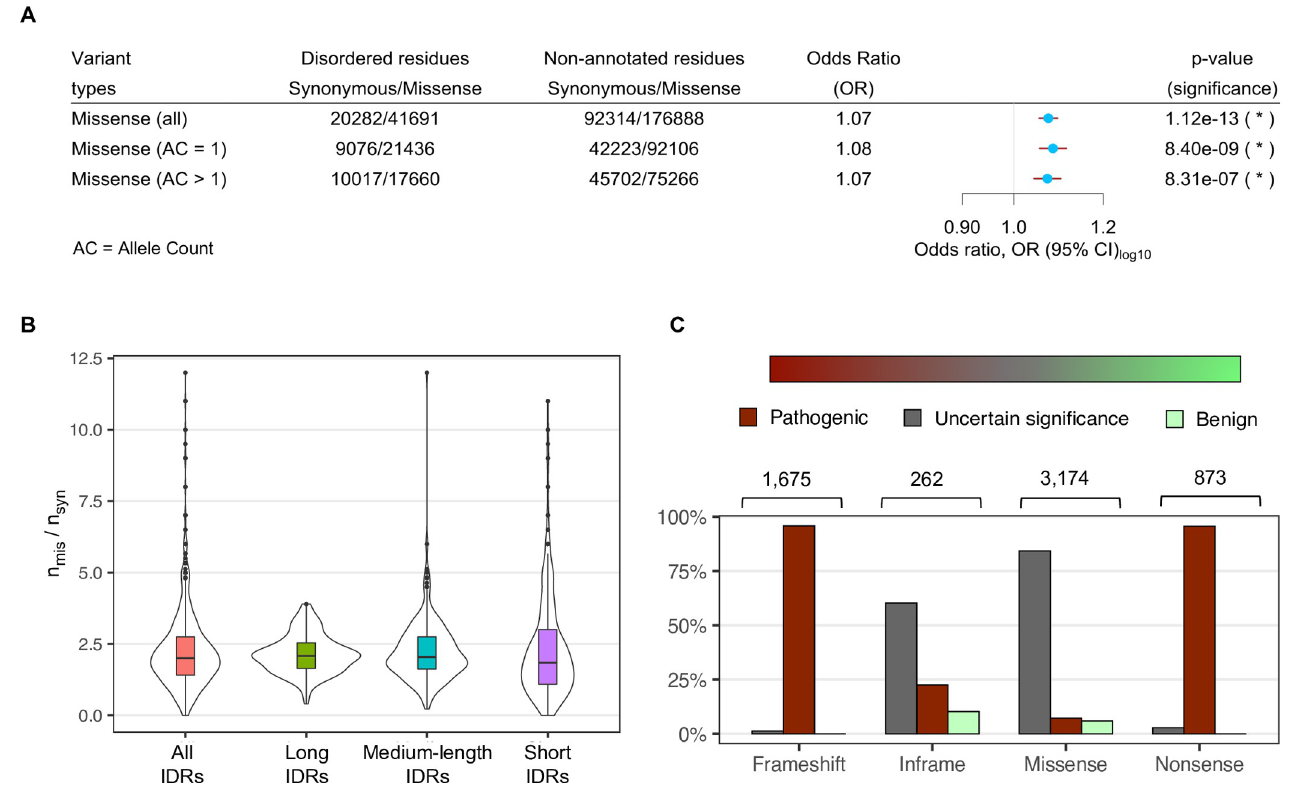
Fig 3. Genetic variations in disordered regions often provide functional advantages to the protein, while for many IDPs, they contribute to the disease phenotype. ( A ) Association of single amino acid-changing missense variations and silent synonymous variations from gnomAD database (a database of variants from relatively healthy individuals) with disordered residues compared to non-annotated residues of 548 human IDPs, calculated using the two-tailed Fisher’s Exact test. Missense variations are marginally (OR = 1.1) but significantly (indicated by “ � ”) enriched in disordered regions, considering all variants together, and also separately in rare (allele count, AC = 1) and frequent variants (AC > 1). ( B ) Distribution of ratios of missense to synonymous (n mis /n syn ) variations from gnomAD database in all IDRs, and short ( � 30 residues), medium-length (30 < residues � 100) and long ( > 100 residues) IDRs. Irrespective of the length, the median of missense-to-synonymous variation ratio in IDRs is over 2.0, showing that point mutations in IDRs can be advantageous. ( C ) Fraction of benign, uncertain significance, and pathogenic mutations of different types (frameshift, inframe, missense and nonsense) observed in patients, affecting disordered regions of 96 human IDPs, collected from ClinVar